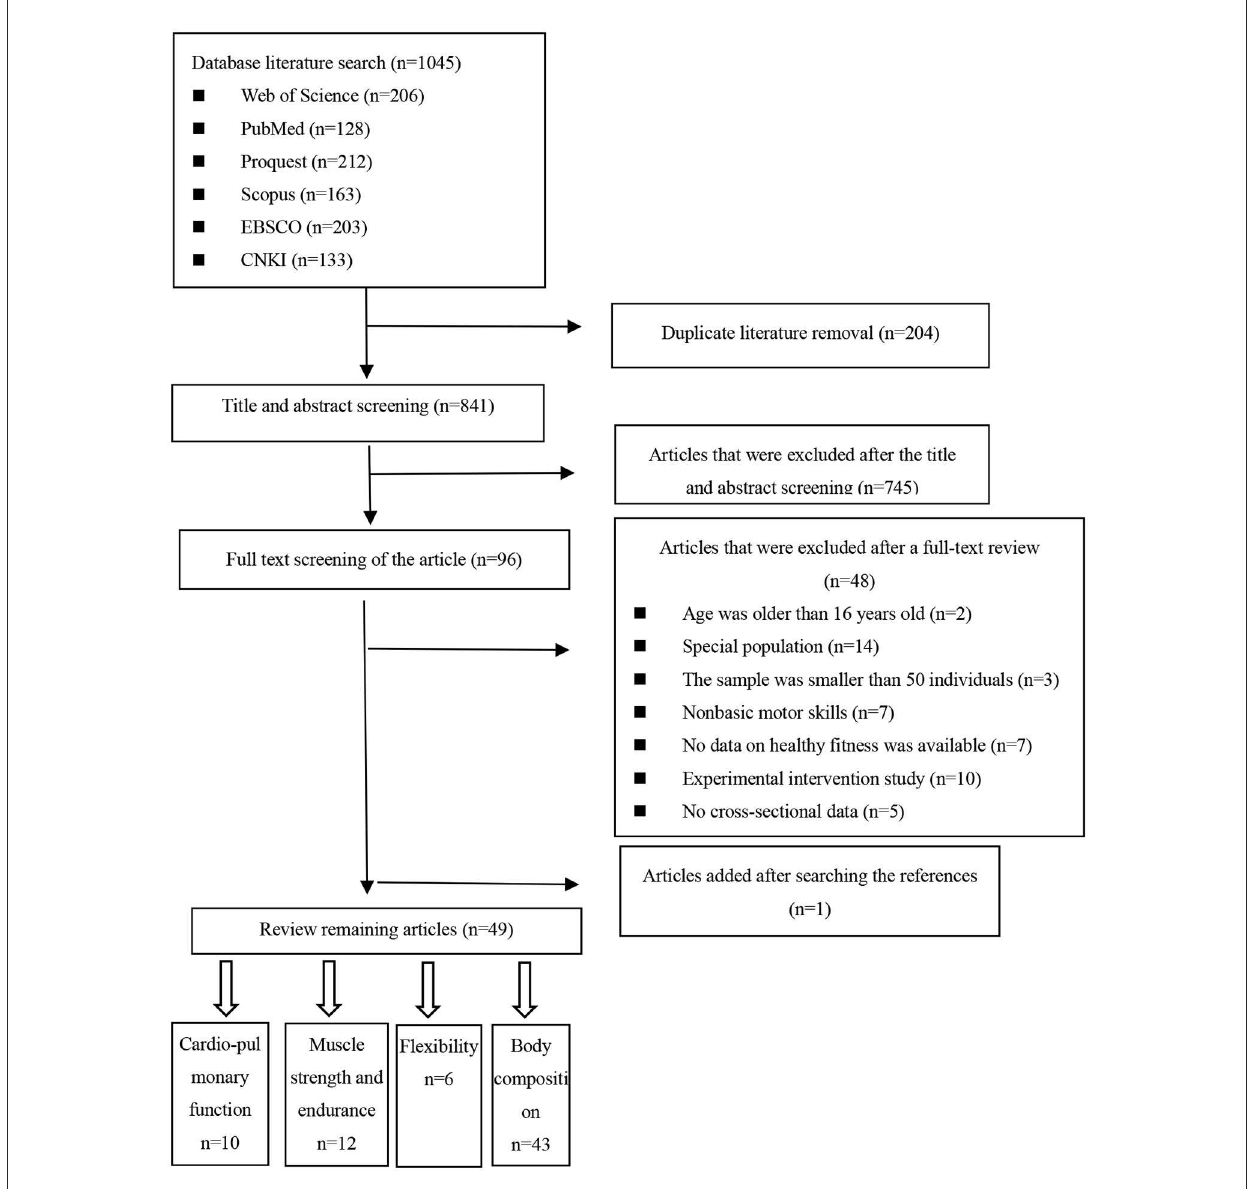
FIGURE1 Flow chart of the literature review process.